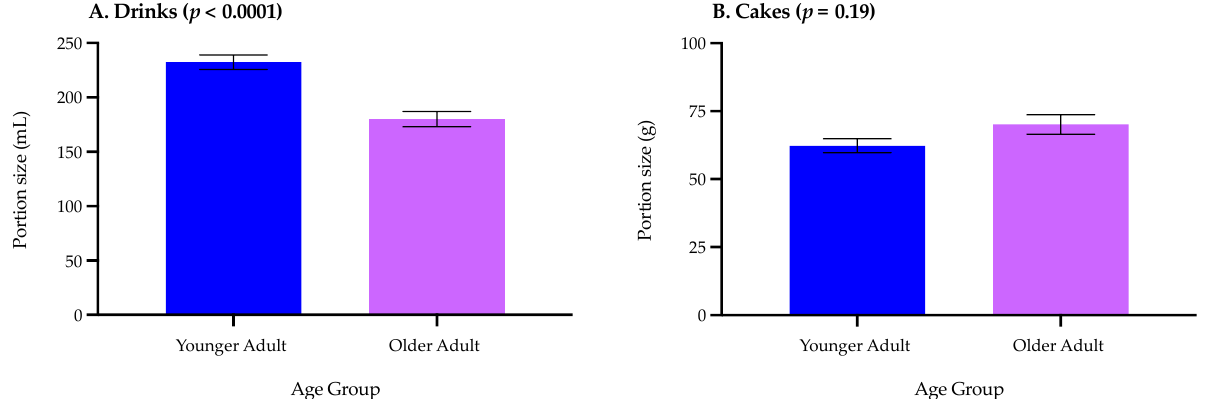
Figure 3. Consumers’ ( n = 73) ideal portion size relating to ( A ) drinks and ( B ) cakes by age (younger adults n = 41 and older adults n = 32). Data reflected all drink and cake types presented (as defined in Table 1) and expressed as means ± standard error.